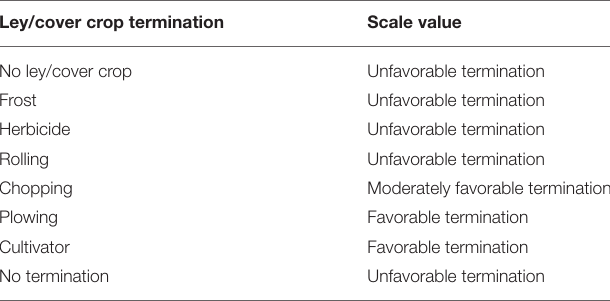
TABLE 4 | Converter of Ley/Cover crop termination